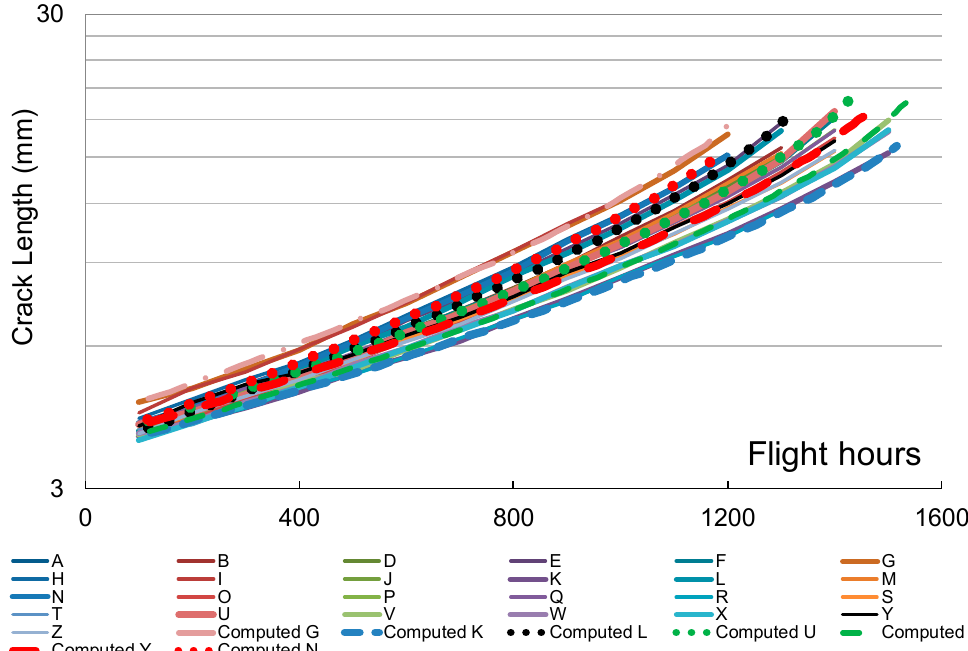
Figure 3. The crack growth history plotted using log-linear axes.